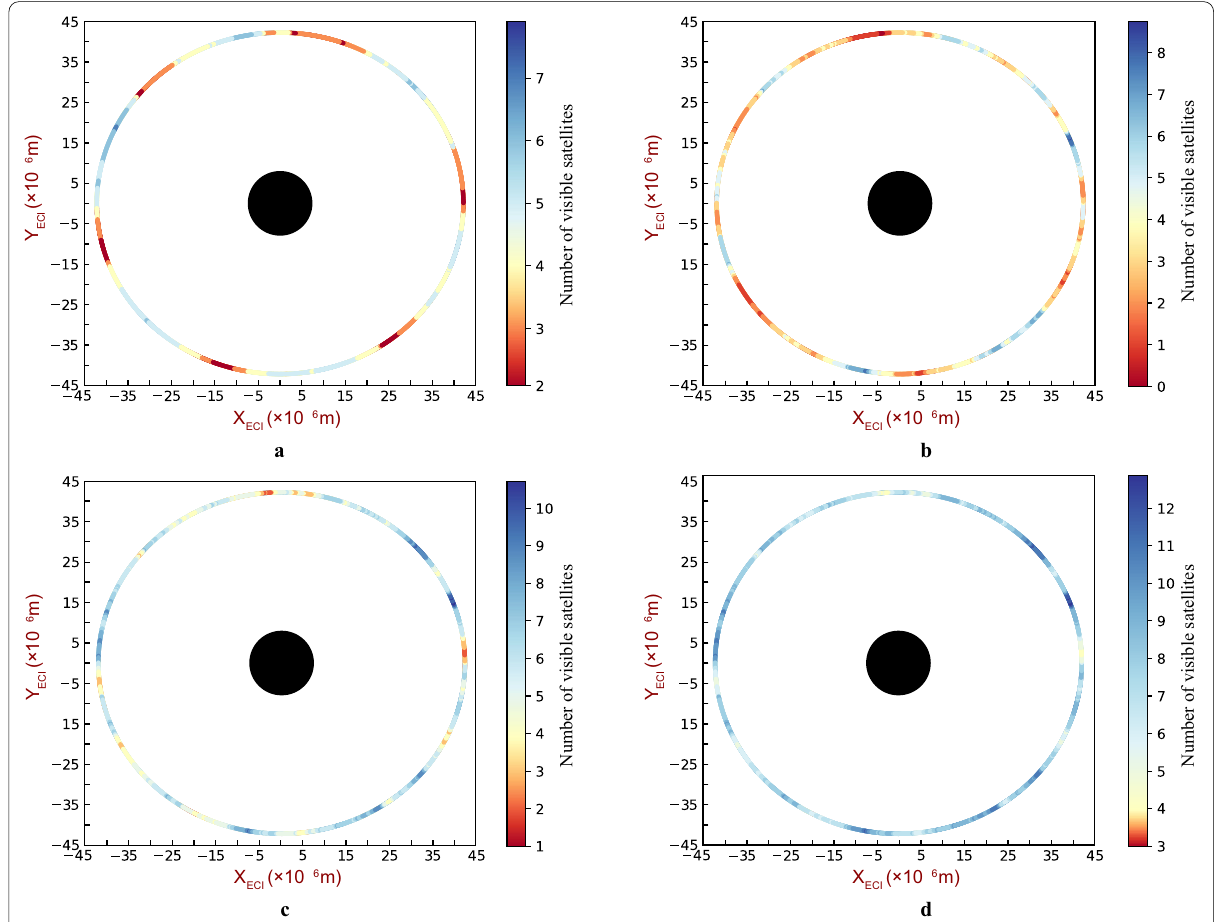
Galileo GLONASS; c + +